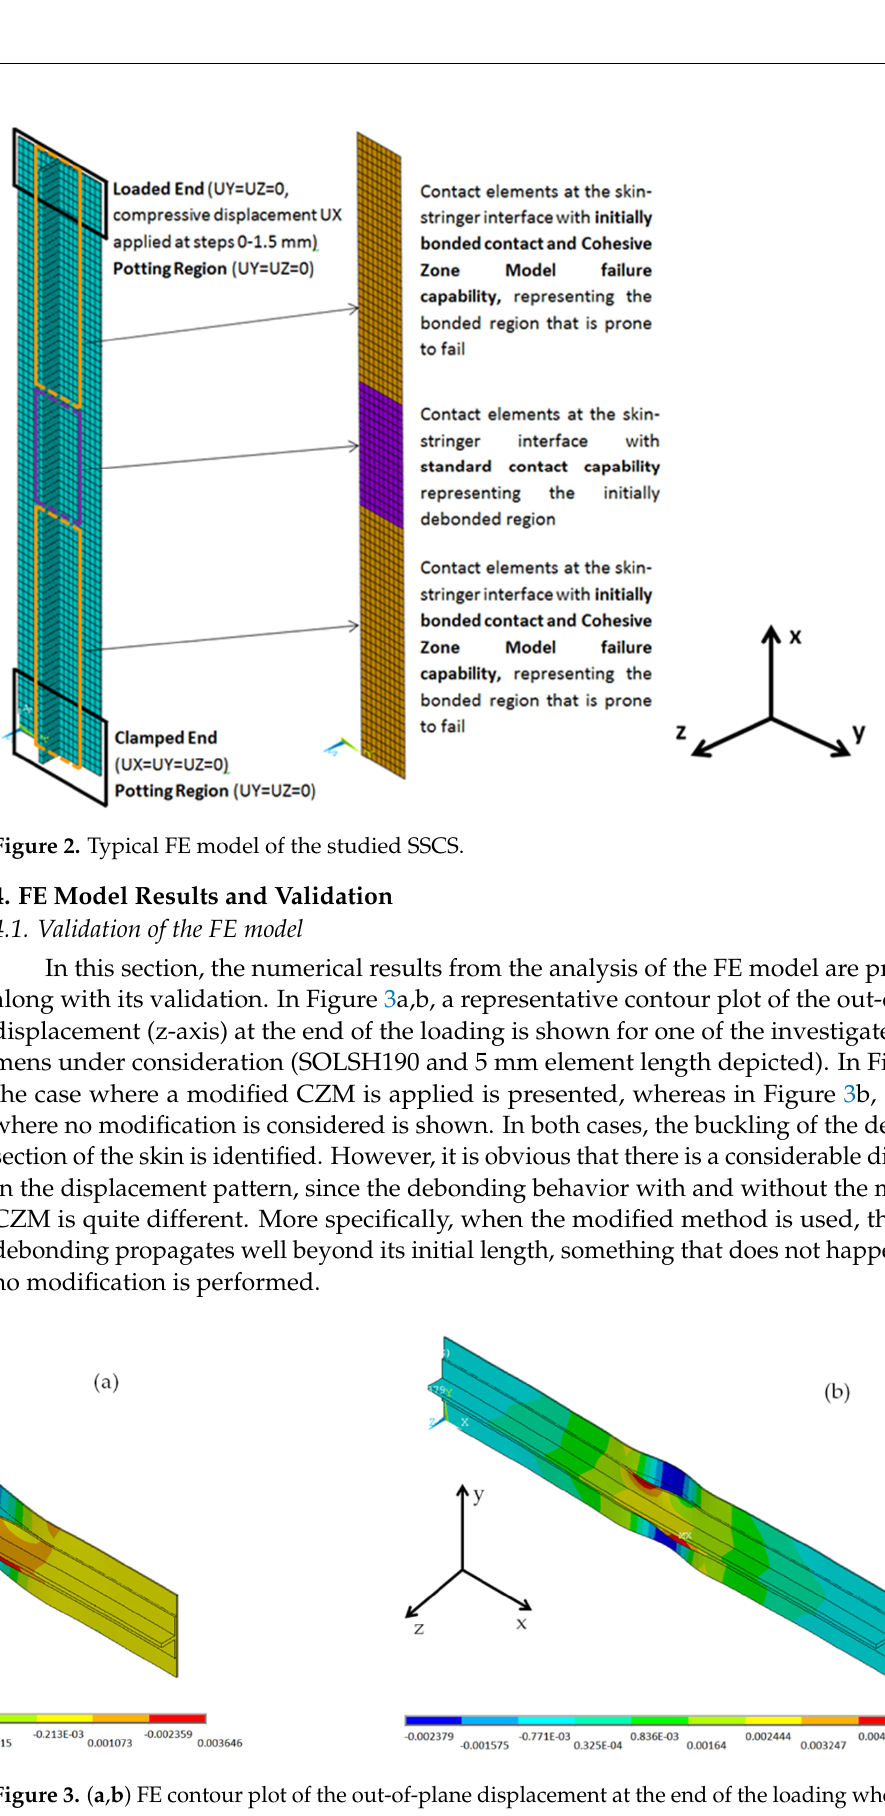
Figure 4. Comparison of the load–displacement curves for SOLSH190 when modified CZM is ap- plied, with experimental and numerical from the literature. In Figure 5, the load–displacement curves for both examined element types (SOLID185 and SOLSH190), for all element lengths and values of CZM parameter N e